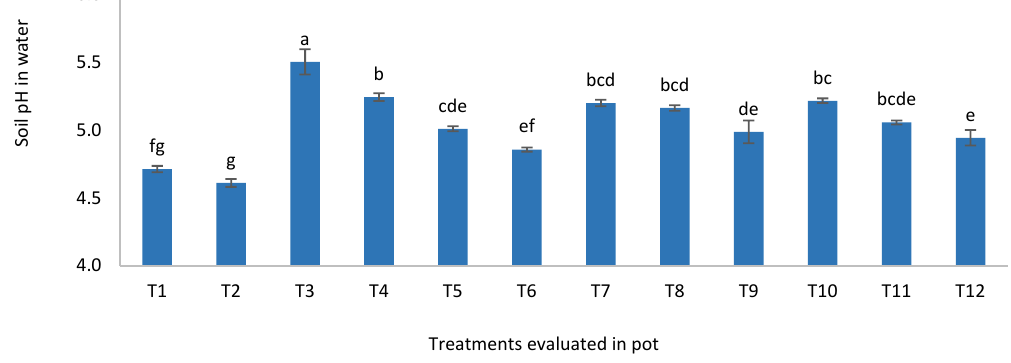
Figure 7. E ff ects of treatments on soil pH in water. Di ff erent letters indicate significant di ff erence Figure 7. Effects of treatments on soil pH in water. Different letters indicate significant difference between means using Tukey’s HSD (Honestly Significant Di ff erence) test at p ≤ 0.05. The error bars are between means using Tukey’s HSD (Honestly Significant Difference) test at p ≤ 0.05. The error bars the ± standard error of are the ± standard error of triplicates.